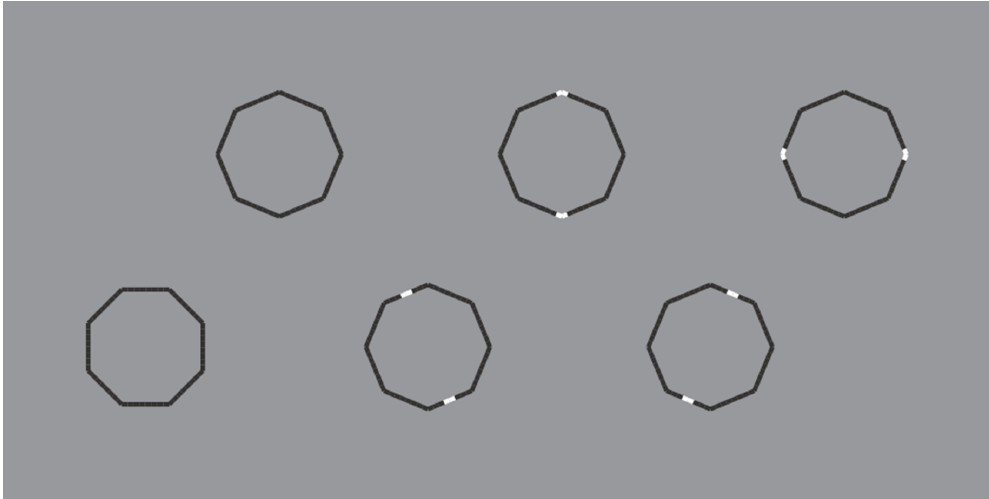
Figure 16. Octagons apparently different due to the accentuation imparted by contrast polarity. In Figure 16 top-center, a regular octagon is perceived with the vertices oriented along the main directions of space (vertical and horizontal). By introducing achromatic discontinuities on two vertices placed along the vertical or on the horizontal axes of the polygon (second and third figure in the first row), the same kind of oriented regular octagon is seen. However, by introducing similar discontinuities in two opposite sides placed along an oblique axes (second and third figure in the second row), the polygons are now perceived as equal and, at the same time, different: Their shapes appear more similar to the first octagon of the second row, i.e., with the sides, rather than the vertices, oriented along the main directions of space. Moreover, the second and third octagons of the second row appear as oriented on opposite oblique directions with respect to the vertical axes.